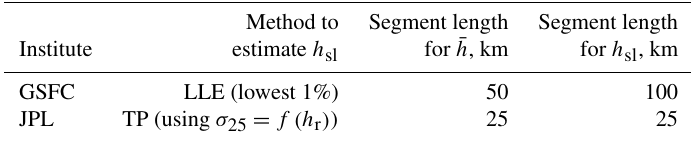
Table 1. Methods and settings used for freeboard retrieval in the GSFC and JPL products. Method to Segment length Segment length Institute estimate h sl for ¯ h , km for h sl ,